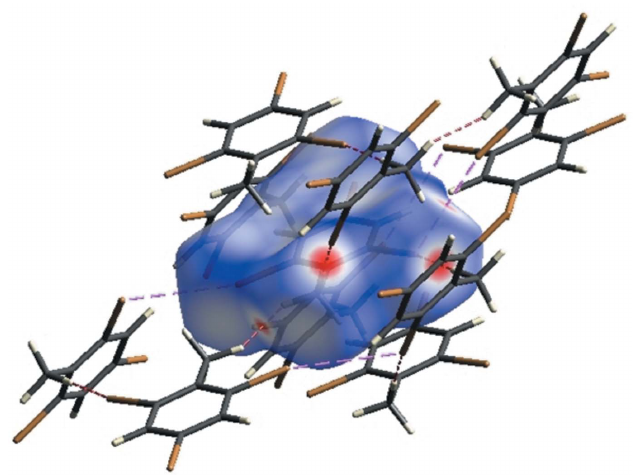
Figure 13 A view of the Hirshfeld surface of TBT mapped over d norm , with interactions shown as dashed oxygen atoms inside the surface and the hydrogen atoms ’ 2.35 A˚ , and has two symmetrical outside the surface, d + d e i points at the top, bottom left and right. The graph shown in Fig. 11 d (H (cid:2) (cid:2) (cid:2) H; 10.6%) shows the two-dimensional finger- print of the ( d , d ) points associated with hydrogen atoms, i e which has two symmetrical wings on the left and right with d ’ 2.3 A˚ . + d i